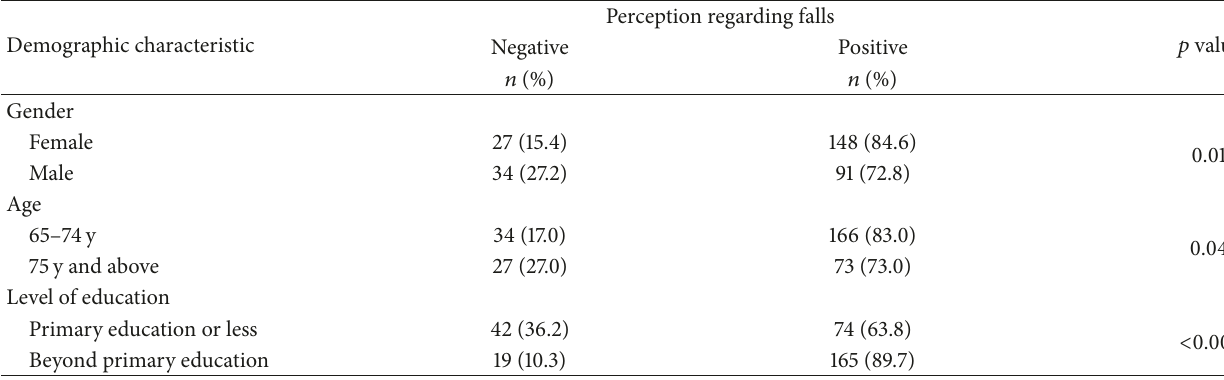
Table 6: Association of perception of falls with demographic variables ( 𝑛 = 300 ).